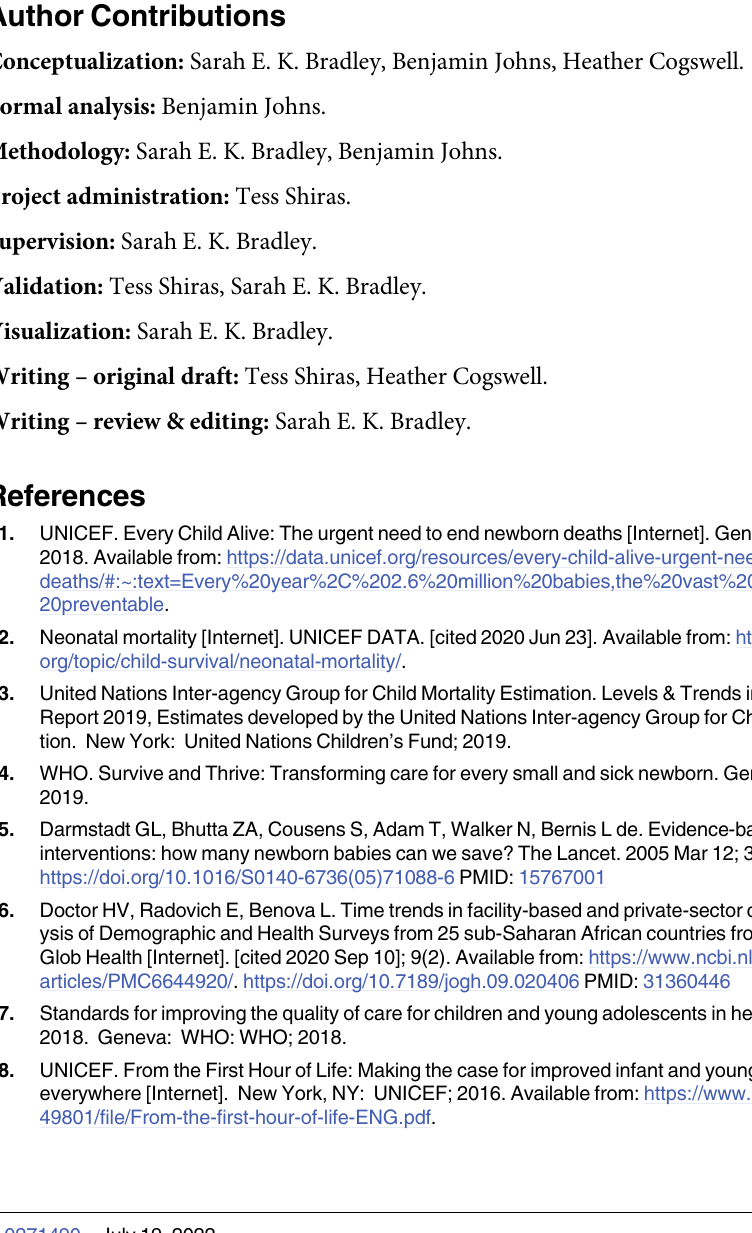
S2 Table. Percentage of newborns who received immediate breastfeeding by C-section sta- tus (includes all facility and attended home births). S3 Table. Percentage of newborns who stayed in the facility for at least 24 hours after deliv- ery by C-section status (includes all facility